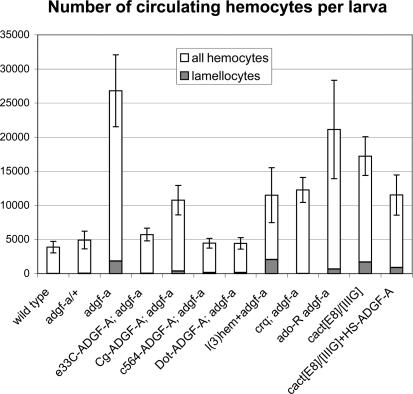
Number of Circulating Hemocytes in Late Third-Instar LarvaeGenotypes are shown along the x-axis, and the number of hemocytes/larva along the y-axis. Each bar shows the number of all circulating hemocytes, and the gray part of the bars represent the lamellocyte population. Each count was repeated five to ten times and the standard error is shown.